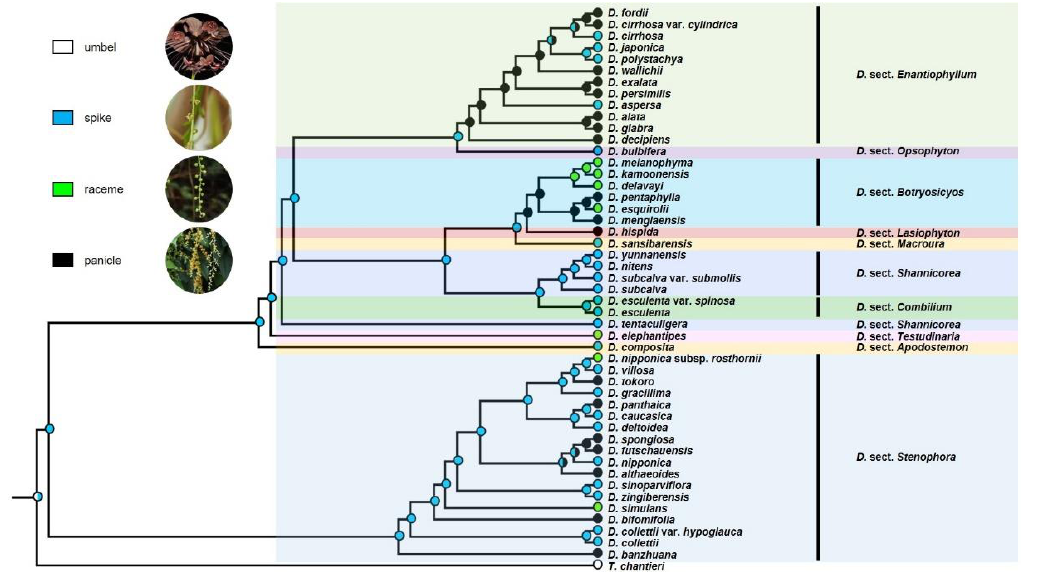
Figure 4. Ancestral character state reconstruction for the inflorescence architecture using the parsi- mony method.